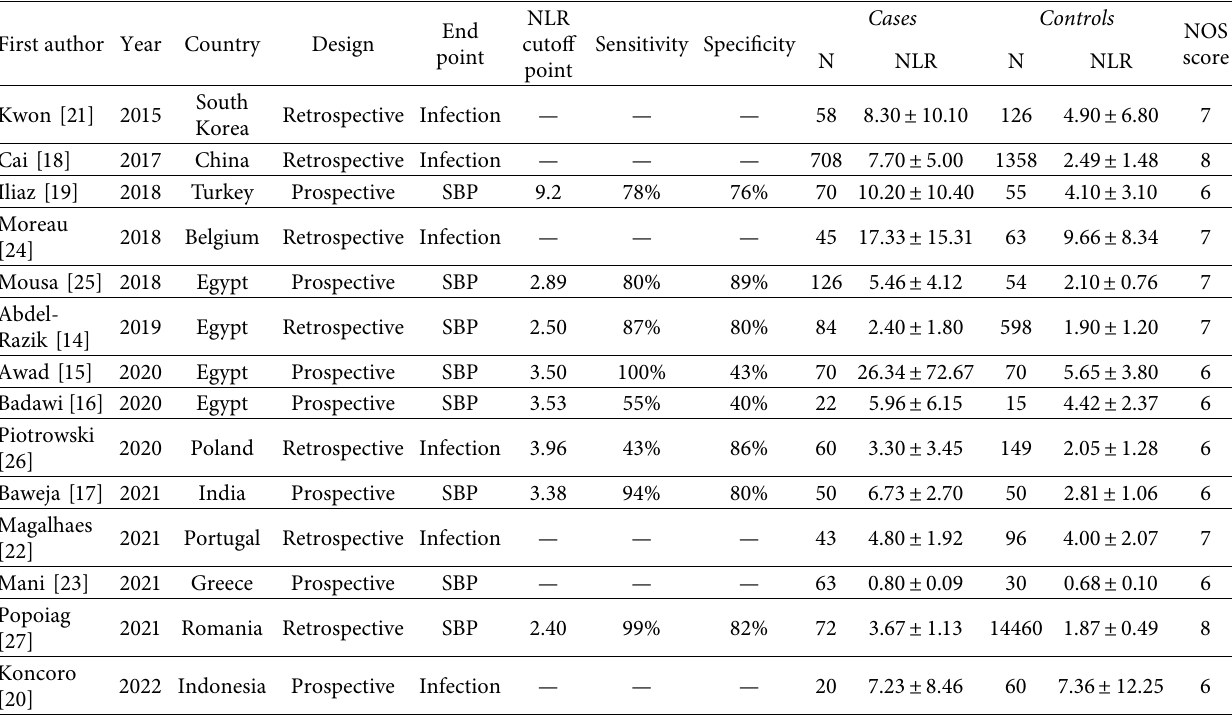
Figure 1: PRISMA 2020 flow diagram for new systematic reviews including searches of databases, registers, and other sources. Table 1: General characteristics of included